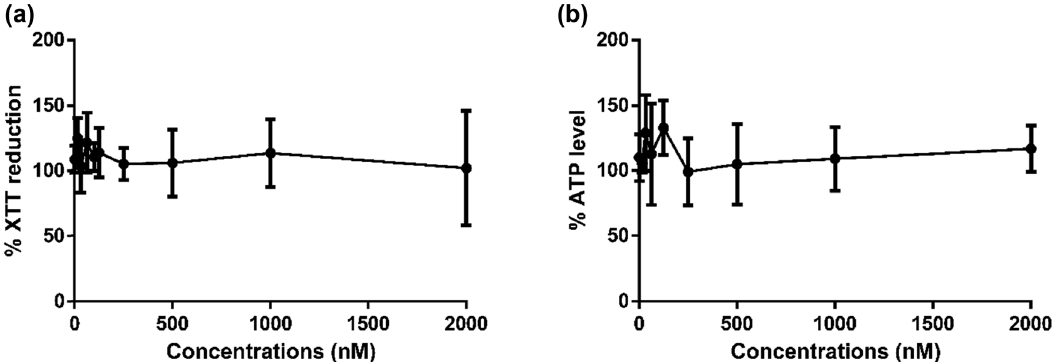
Figure 1: Cytotoxicity of ochratoxin A on microglial BV - 2 cells. BV - 2 cells were incubated with di ff erent concentrations of OTA ( 31.25, 62.5, 125, 250, 500, 1,000, and 2,000 nM ) for 24 h. ( a ) Cell viability examined by XTT reduction assay. ( b ) ATP levels measured by CellTiter - Glo ® luminescence assay kit. Results are expressed as a percentage of the control ( 100% ) . Values are mean values ± SD of at least three independent experiments. ( Figure 2a ) in a dose - dependent fashion, albeit with dif - ferent levels of expression. iNOS mRNA expression was the highest compared to the other genes. The concentra - tions of IL - 6 and NO released into the culture media were determined using ELISA and Griess reagent, respectively. The results showed that OTA - treated BV - 2 signi fi cantly increased IL - 6 and NO production in a concentration - dependent manner when compared to controls. Consistent